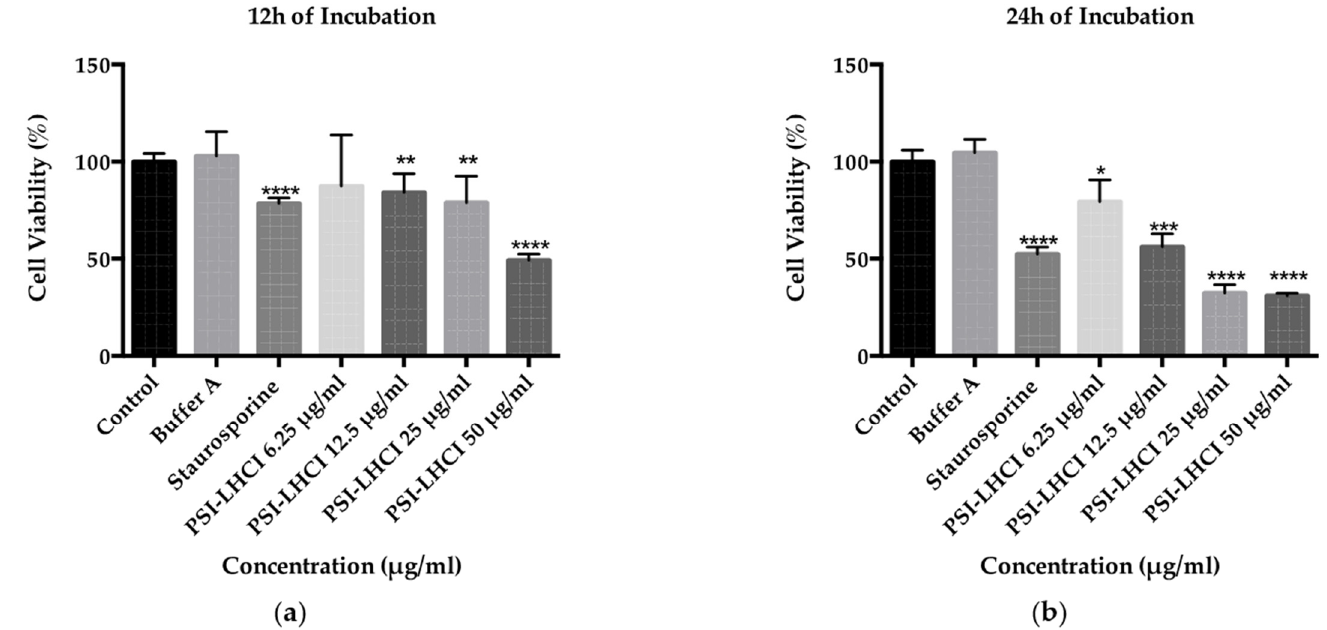
Figure 4. Time and concentration-dependent effect of PSI-LHCI in MDA-MB-231 cells; ( a ) effect of PSI-LHCI in cell viability following treatment with different concentrations (6.25–50 µ g/mL) after 12 h of incubation. Asterisks indicate statistical significance with ** p < 0.01 and **** p < 0.0001; ( b ) effect of PSI-LHCI in cell viability following treatment with different concentrations (6.25 to 50 µ g/mL) after 24 h of incubation. Incubation with the extraction buffer A at the highest concentration tested (50 µ g/mL) was used as an experimental control. Staurosporine (2 µ M) was used as a positive control. Untreated cells were used as a negative control. Asterisks indicate statistical significance with * p < 0.05, *** p < 0.01 and **** p < 0.0001. Data shown are expressed as mean ± SD performed in triplicate, where n = 8, and the statistical method performed used the two-way analysis of variance